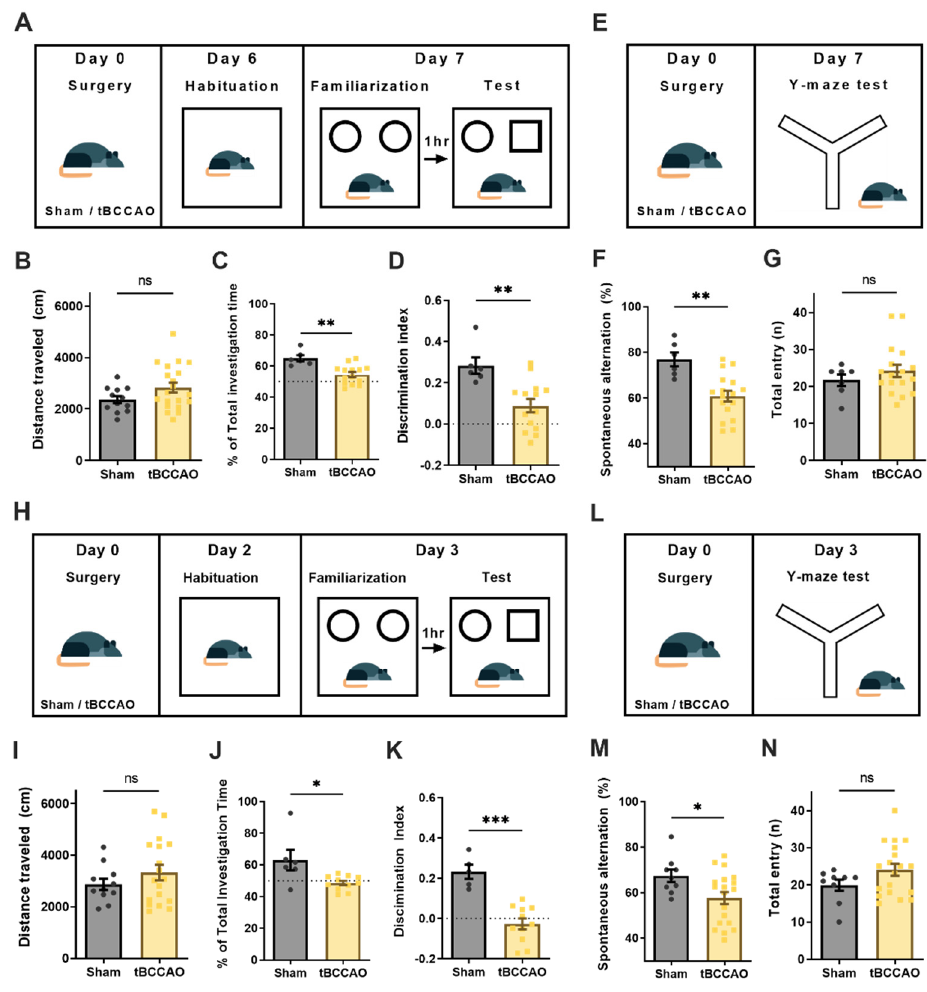
Figure 3. Cognitive impairments induced by transient bilateral common carotid artery occlusion (tBCCAO). Recognition memory and short-term working memory were evaluated using the novel object recognition test (NOR) and Y-maze test, respectively, after 7 days and 3 days. ( A ) Experimental scheme of the NOR test after 7 days. ( B ) Locomotion evaluated by travel distance in the open area